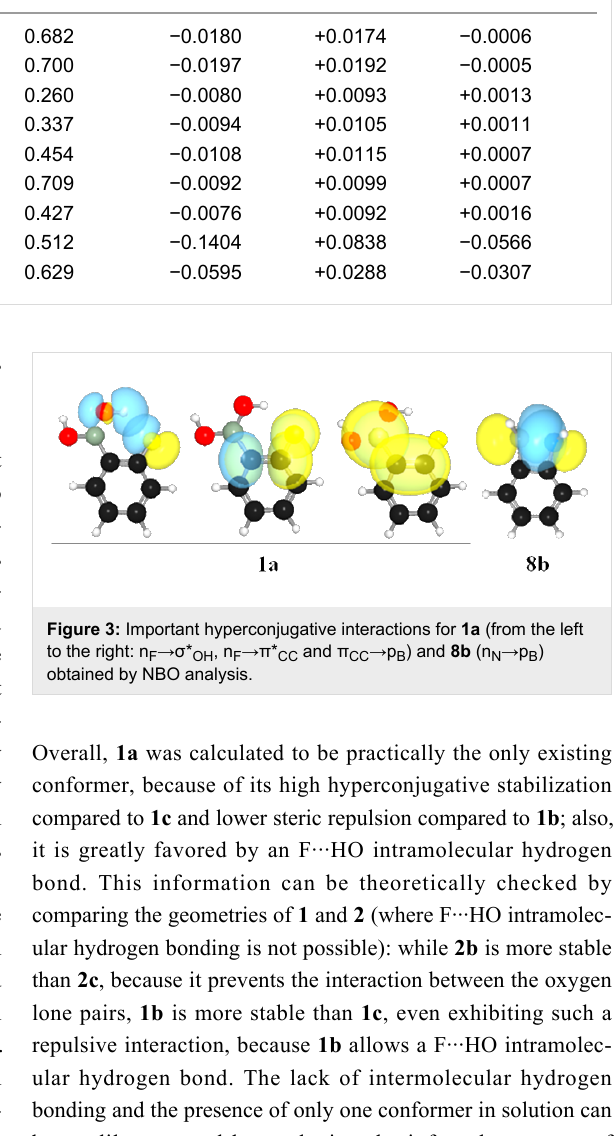
Table 2: QTAIM parameters useful to characterize the formation of bonds for 1a–9c . Conformers